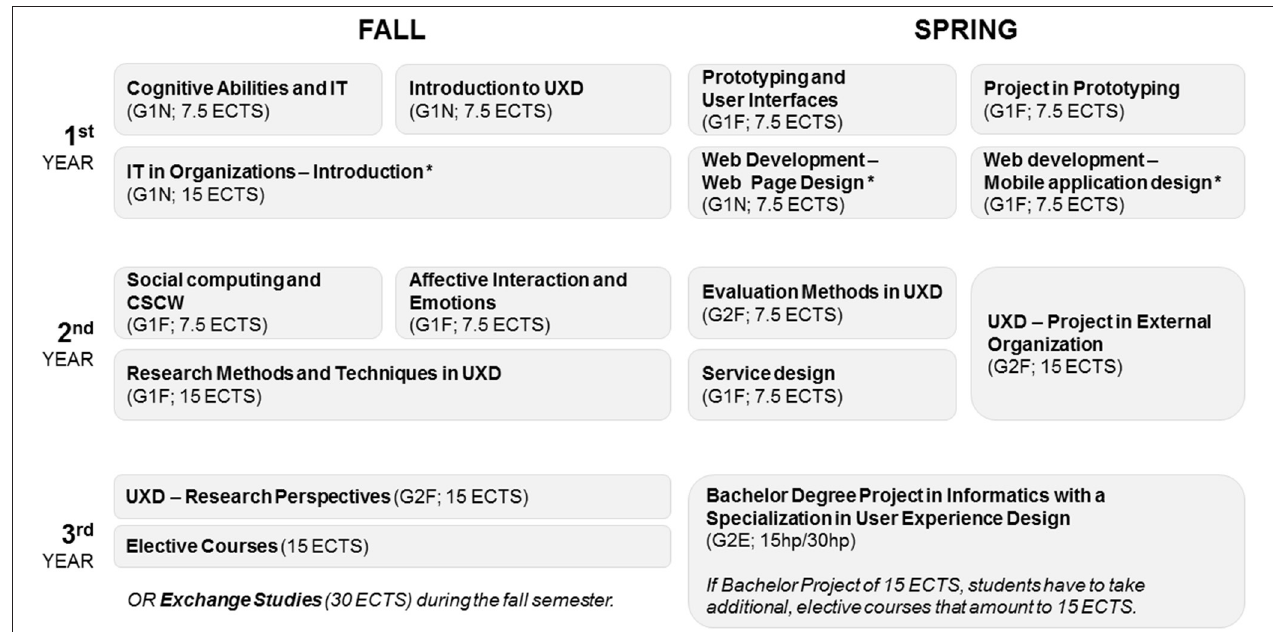
FIGURE 1 | Overview of courses in the UXD program. Most are program specific but three are supportive courses from other programs and are marked with